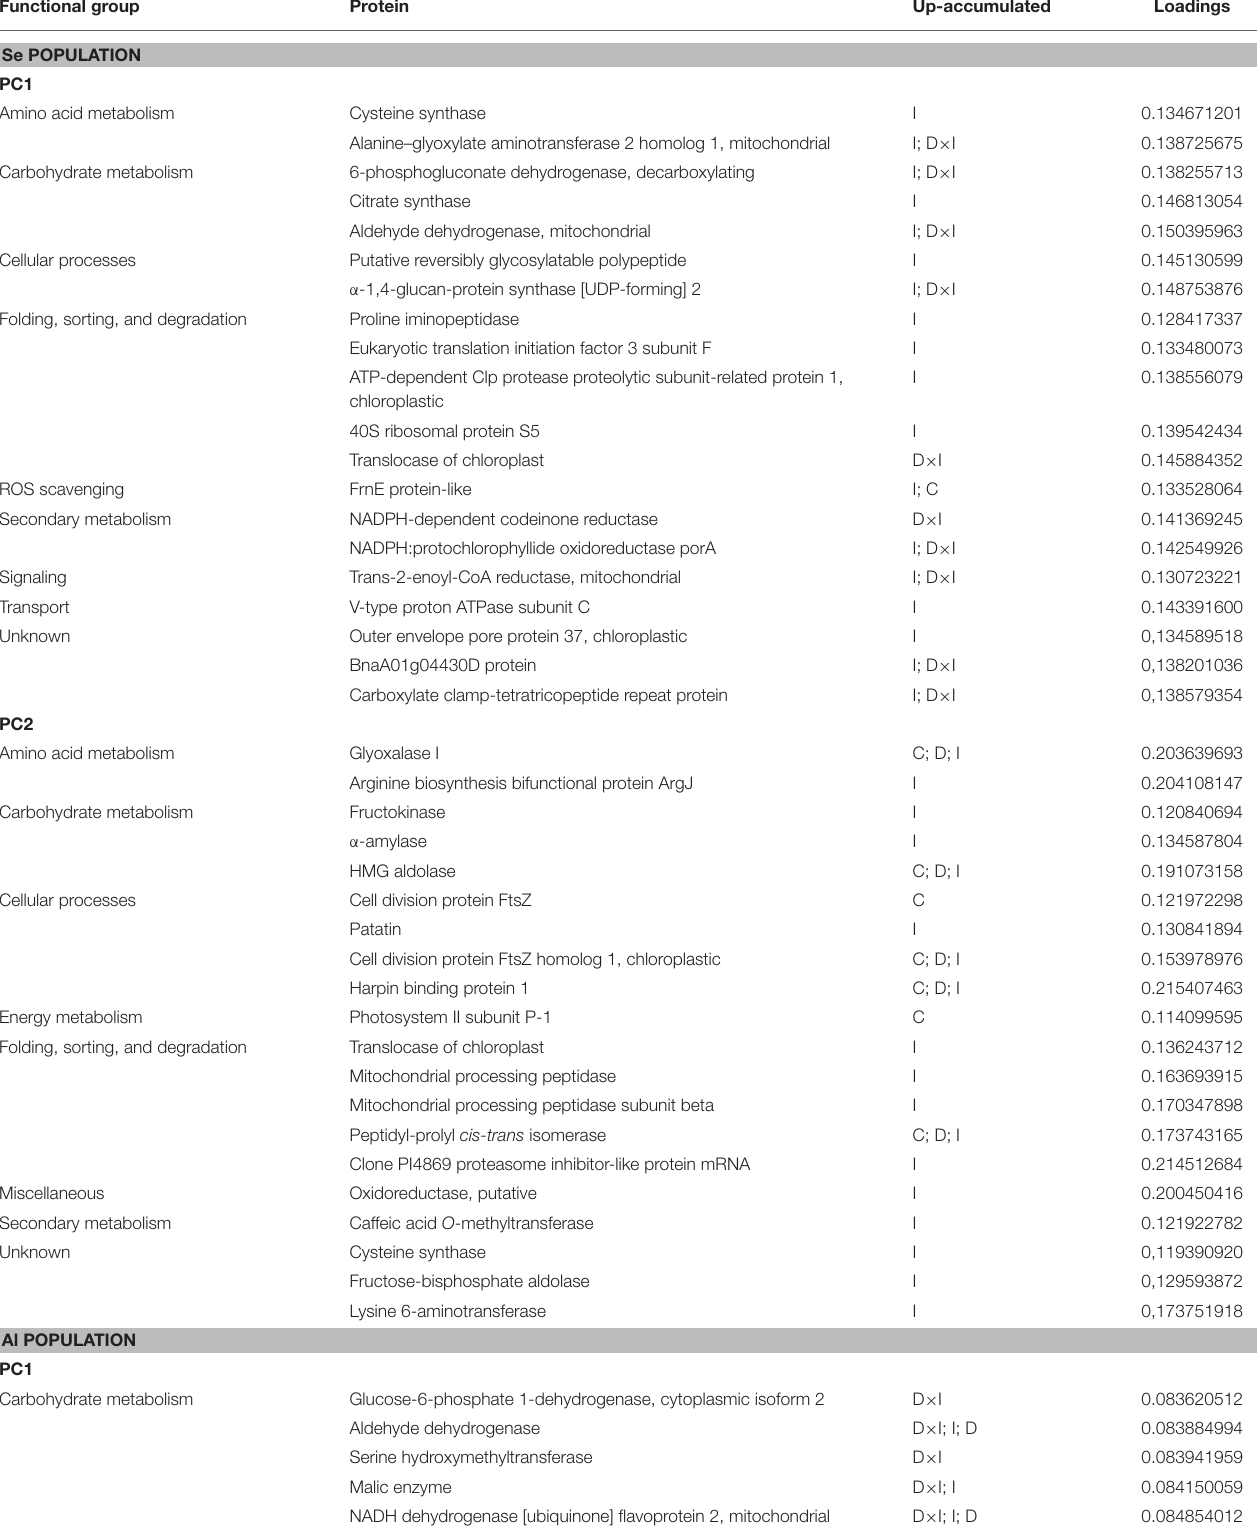
TABLE 3 | First 20 proteins with positive loadings contributing to PC1 and PC2 in the Seville (Se) and Almeria (Al) populations as classified by functional group. Functional